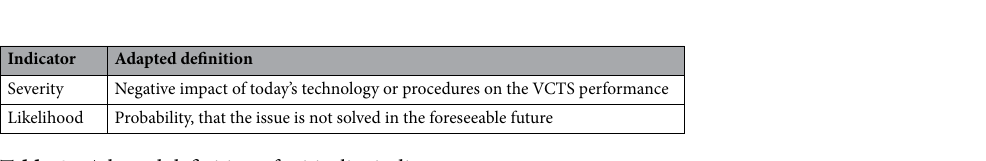
Table 4. Adapted definition of criticality